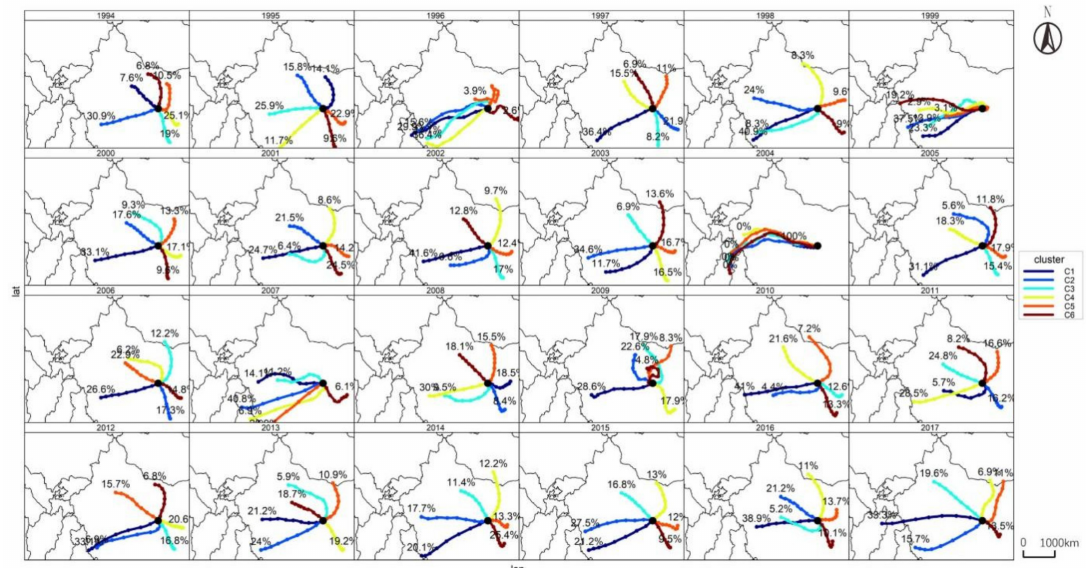
Figure 7. The 96-h backward trajectory cluster in 6 from 1994–2017. According to the analysis of the potential sources from Figure 8, pollutants mainly came from the northwest and west sides. The concentration of pollutants gradually in- creased from 2003 to 2012, and the scope of pollution expanded from northwest China to western China and North China. The concentration of pollutants gradually decreased from 2012 to 2017, during which severe polluted events only occur in the northwest and in North China. It is mainly related to China’s emission reduction policy. In addition, from 2003 to 2007 and 2010 to 2013, the southwest pollution contributed significantly, which verified the conclusion obtained in Figure 7. In addition, from 1998 to 2012 to 2016, the east contributed more, corresponding to the figure above. The peak annual average black carbon concentration appeared in the ENE wind direction, with the value of 4.6 × 10 2 ng m − 3 , and the second peak value appeared in the E wind direction, with the value of 3.9 × 10 2 ng m − 3 . The concentrations in NE, ENE, and E wind directions are high, reflecting the effect of black carbon aerosol generated by human activities in the east of the station on the observed values.